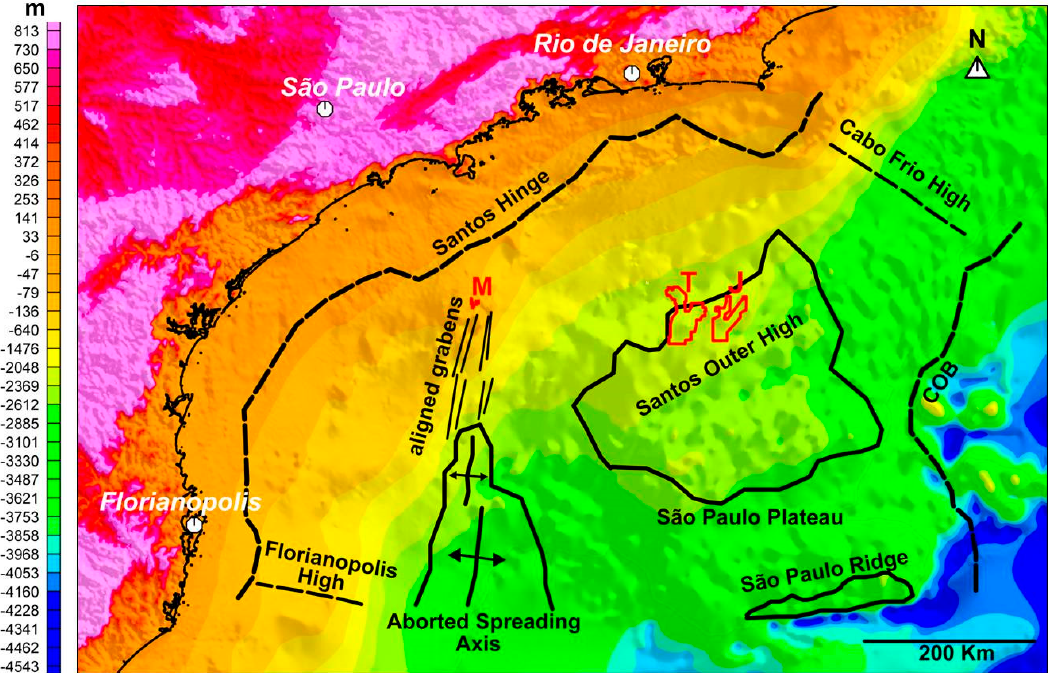
Figure 3. Santos Basin main structural features obtained from the potential methods interpretation, plotted on the bathymetric map. M and T are the locations of the Merluza and Tupi fields. J is the location of Jupiter prospect. COB corresponds to the continent–ocean boundary.